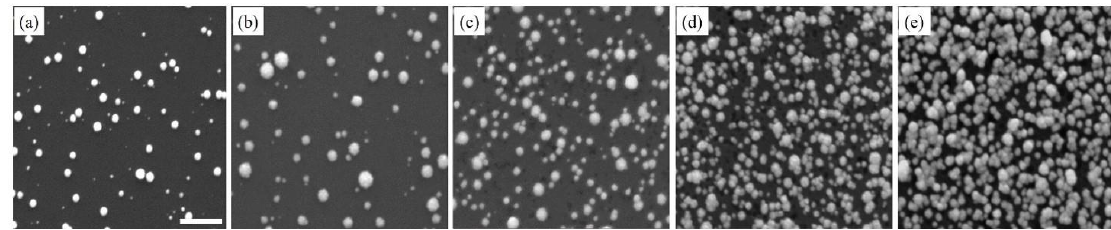
Figure 2. The Pt nanostructures are seen in SEM images. These images were taken at different stages of the deposition process, beginning with the completion of the first deposition cycle ( a ), followed by the third ( b ), fifth ( c ), eighth ( d ) and tenth ( e ) deposition cycles. The scale bar is 500 nm.